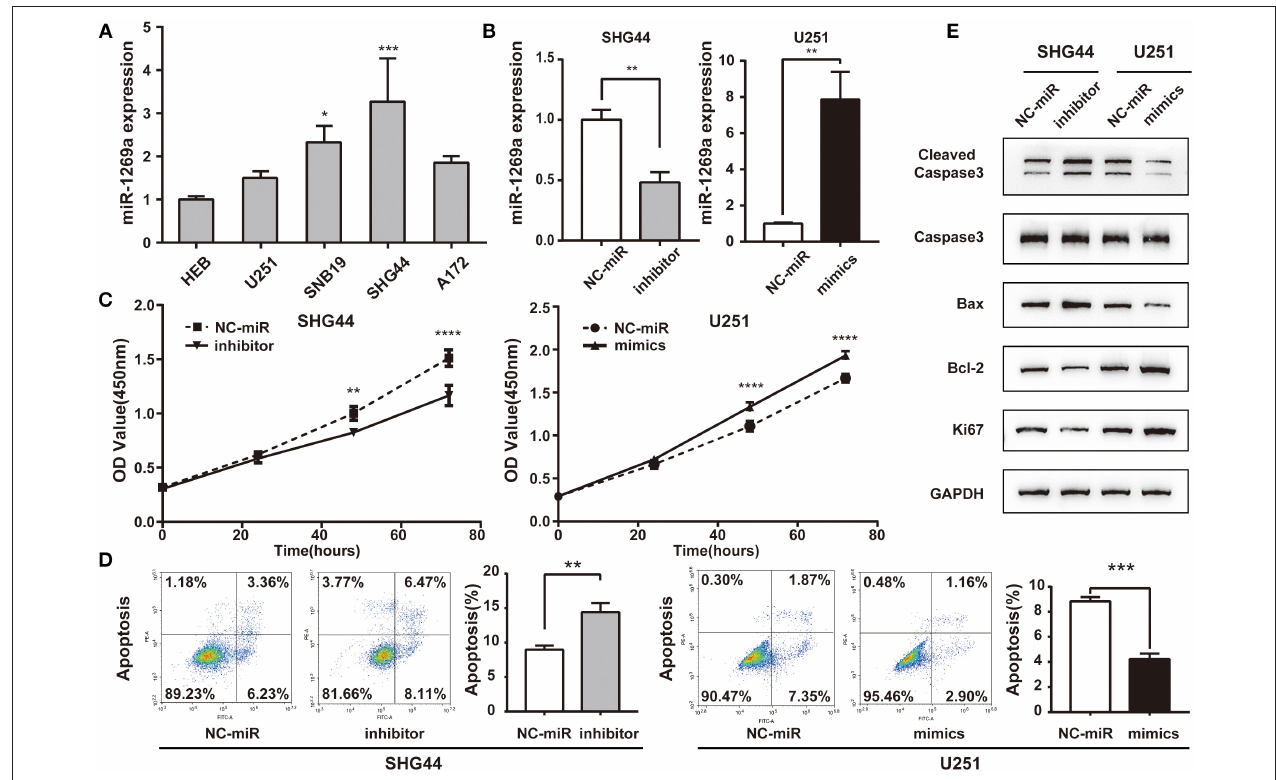
FIGURE 2 | miR-1269a is overexpressed and promotes proliferation and inhibits apoptosis in glioma cells. (A) The relative expression levels of miR-1269a in five human glioma cell lines (U251, SNB19, SHG44, and A172) and HEB cell line. (B) Transfection efficiency of the miR-1269a inhibitor in SHG44 and mimics in U251 was determined via qPCR. (C) Cell proliferation was determined via the CCK8 assay. (D) Cell apoptosis was determined via the flow cytometry assay. (E) The protein expression levels of proliferation (Ki67) and apoptosis (cleaved caspase 3, caspase 3, Bax, and Bcl-2) were detected using Western blot. * P < 0.05, ** P < 0.01, *** P < 0.001, and **** P <